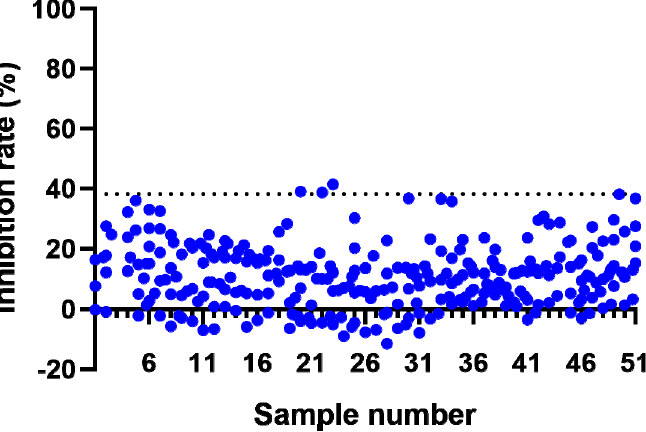
Figure 2. The cut point for the confirmation assay. The confirmation assay was carried out in six runs by three analysts. The confirmatory cut point (CCP) is shown with the blue dotted line.